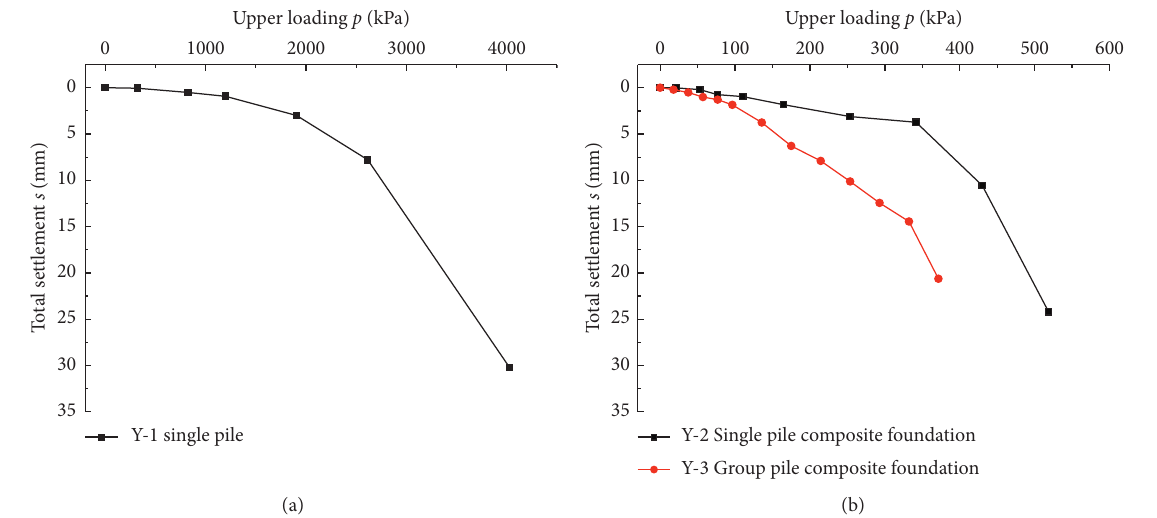
Figure 5: Loading-settlement curves ( p − s curve) in laboratory model tests. (a) Y-1 single pile; (b) Y-2 single pile, and Y-3 group pile composite